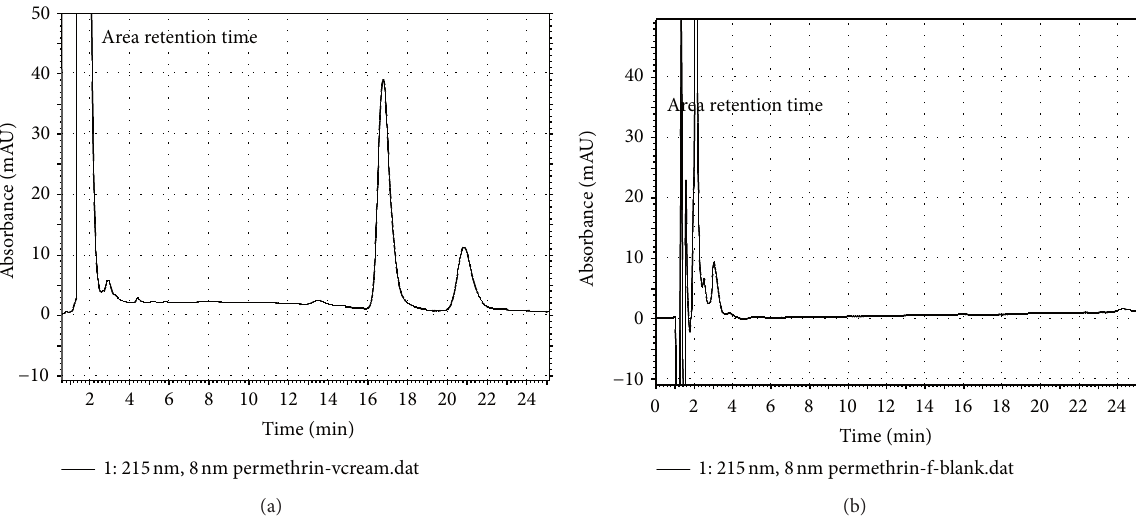
F 4: A chromatogram obtained from analyzing of the commercially available cream. e solution contains the target